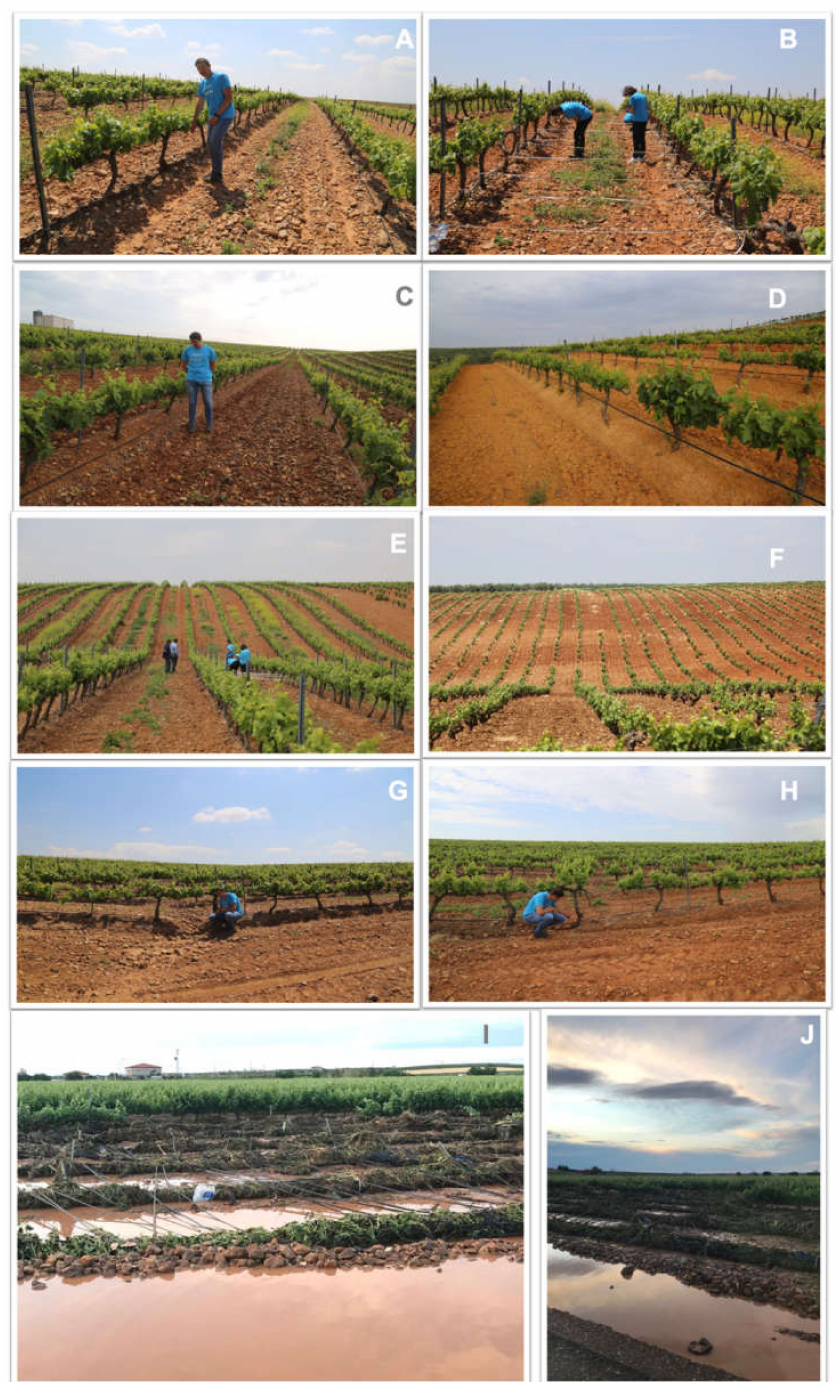
Figure 2. ( A–D ) View of the undulating landscape and the incision in the lower slope position (talwegs). ( E–H ) View of the ridges formed by the tillage and water erosion at the study site. ( I–J ) The impact of a rainfall event of a total amount greater than 42 mm in 2 hours and the economic damage of the soil erosion a ff ects the farmers’